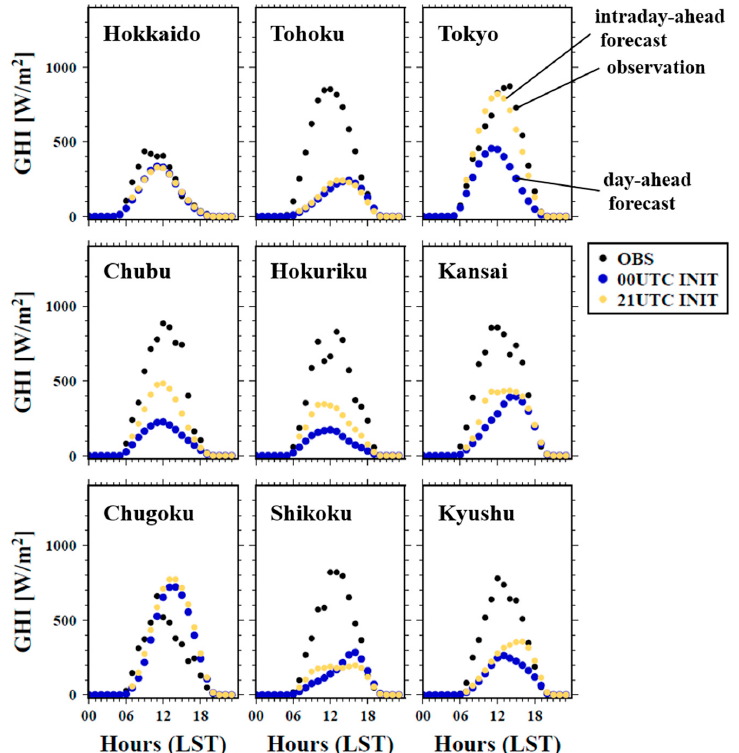
Figure 13. Same as Figure 4, but for 11 July 2017.